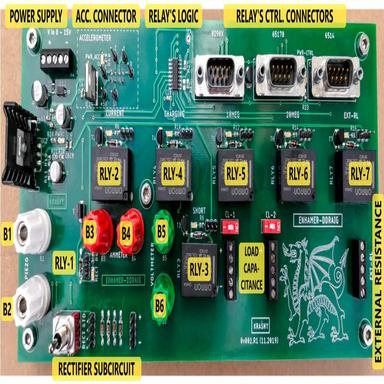
Assembled Ddraig Control Board with visible sub circuits parts responsible for power conditioning and relays control, relays, control connectors, piezoelectric input connectors and load components connectors (resistance, capacitance). .